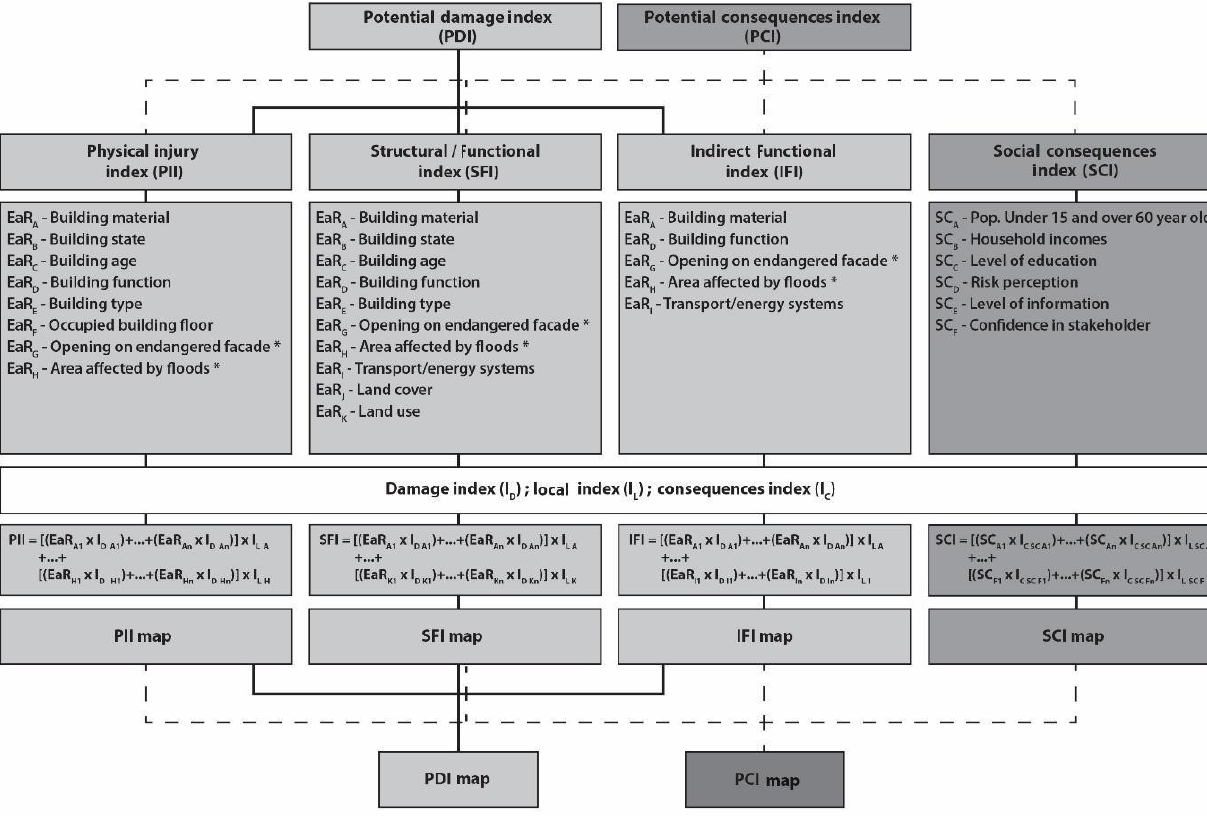
Figure 3. Framework of the Potential Damage Index (PDI) compared to the Potential Consequences Index (PCI).